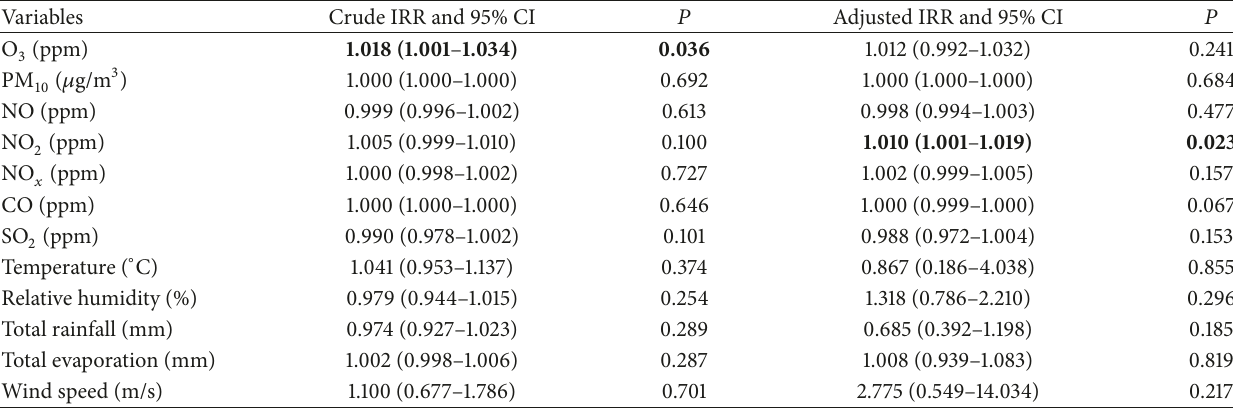
Table 4: Results of crude and adjusted negative binomial regression and of the effect of pollutants and climate factors on respiratory hospital admissions (ratio of increase in hospital admissions in day per unit of increase in pollutants and climate factors daily average) in the nonepidemic